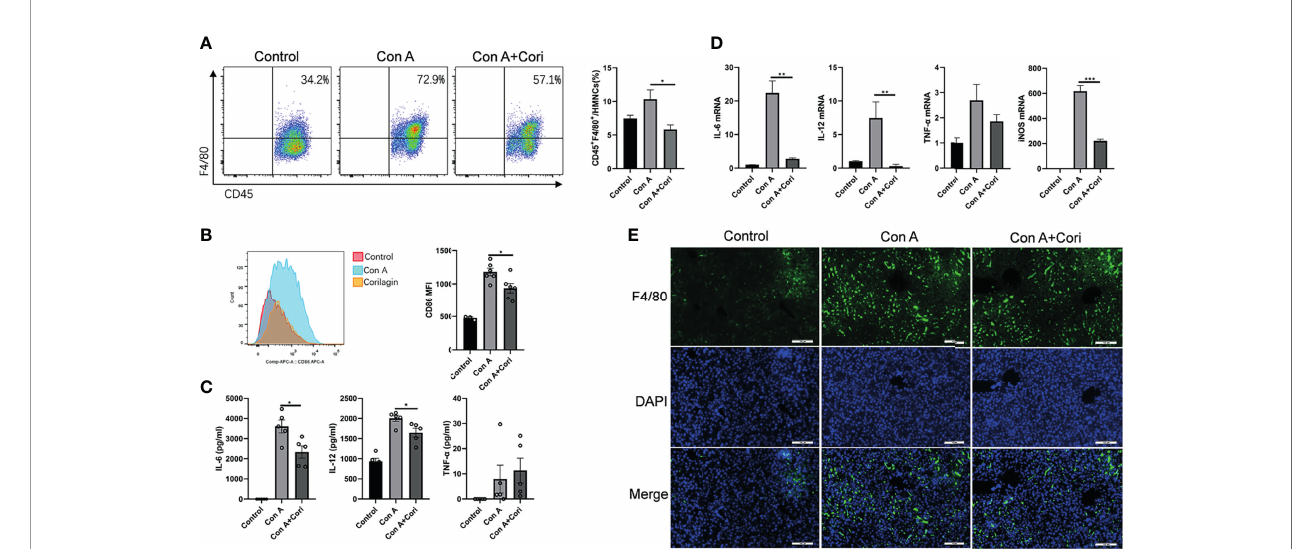
FIGURE 3 | Corilaginprotectsagainst ConA-inducedliver injurybyregulatingthe activationofM1macrophages.Mice were administeredcorilagin(25 mg/kg)intraperitoneally twice at timeintervals of12 h. After 1h, micewerechallengedwithCon A(20mg/kgbody weight). Liver tissues were collected12 hlater. (A) Detectionofthe macrophageratio in mouse hepatic mononuclear cells (HMNCs) by fl ow cytometry. (B) CD86 mean fl uorescence intensity (MFI). (C) In fl ammatory cytokines interleukin (IL)-6, IL-12, and tumor necrosis factor- a (TNF- a ) in the serum measured by ELISA. (D) IL-6, IL-12, TNF- a , and inducible nitric oxide synthase (iNOS) levels in the liver tissue measured by qRT-PCR. (E) Macrophage in fi ltration in the liver tissue 200×. *p < 0.05, **p < 0.01, ***p <